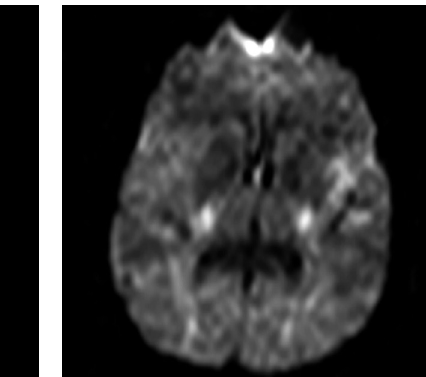
Figure 3. Brain Diffusion Magnetic Resonance Imaging in axial section showing restricted dif- fusion in the cortical region of the left insular